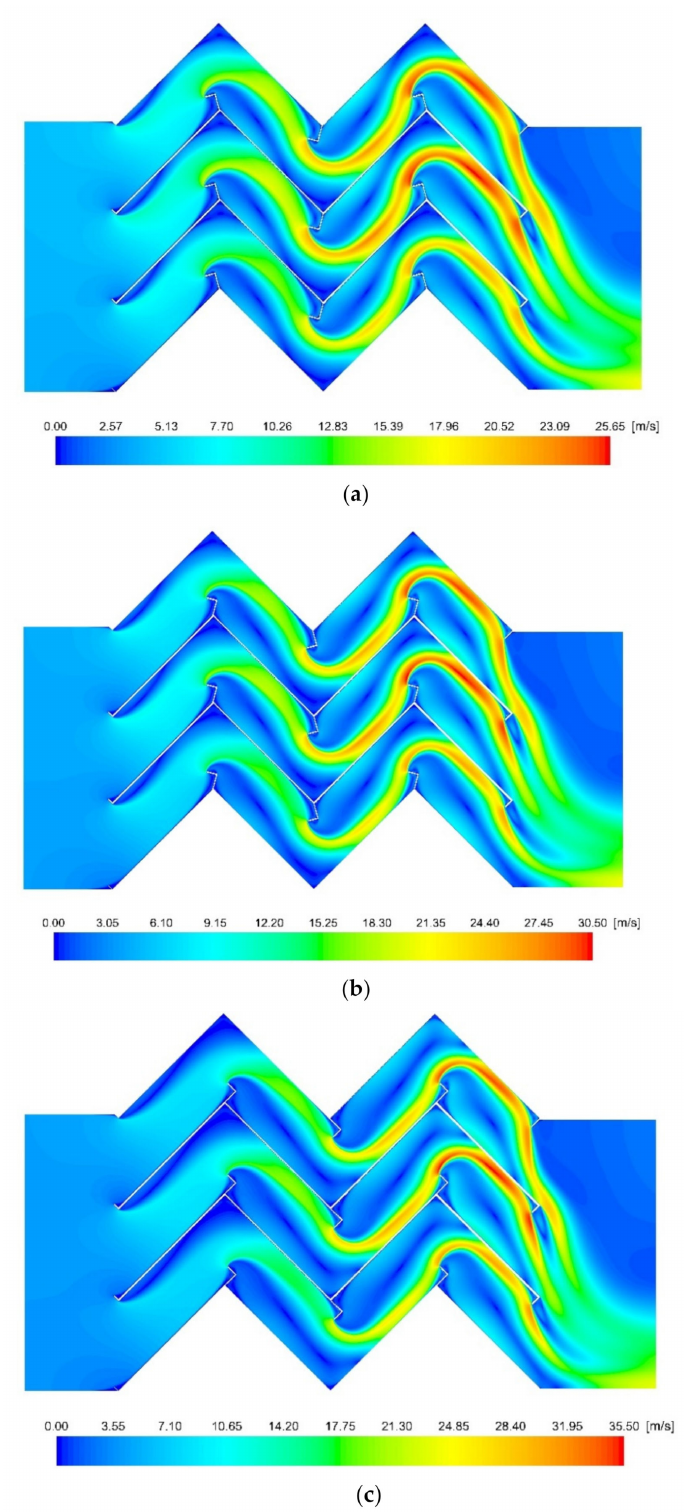
Figure 14. Velocity fields (m s − 1 ) of investigated geometry variants with different drainage channel angles: ( a ) B_10_30; ( b ) B_10_60; ( c ) B_10_90; for inlet velocity 4 m s − 1 , simulated using a transition SST